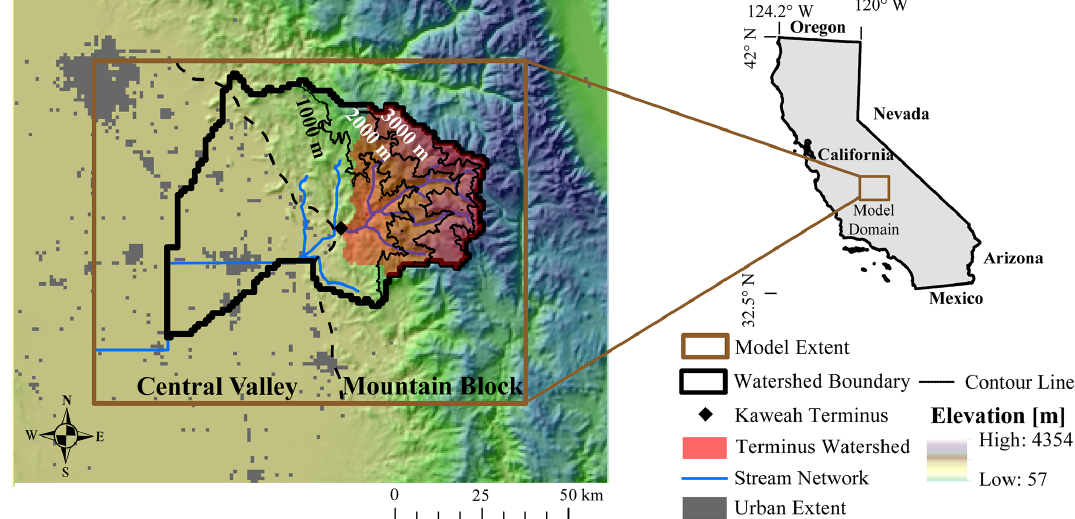
Figure 1. The location of the model domain within the state of California, USA. A 30m digital elevation model is used to delineate the Kaweah Terminus watershed and Kaweah River watershed boundaries. The model extent is larger than the watershed boundary to reduce the impact of boundary conditions on simulated groundwater flow. The dashed line indicates the boundary between the mountain block and Central Valley aquifer system defined by using a geologic map of the